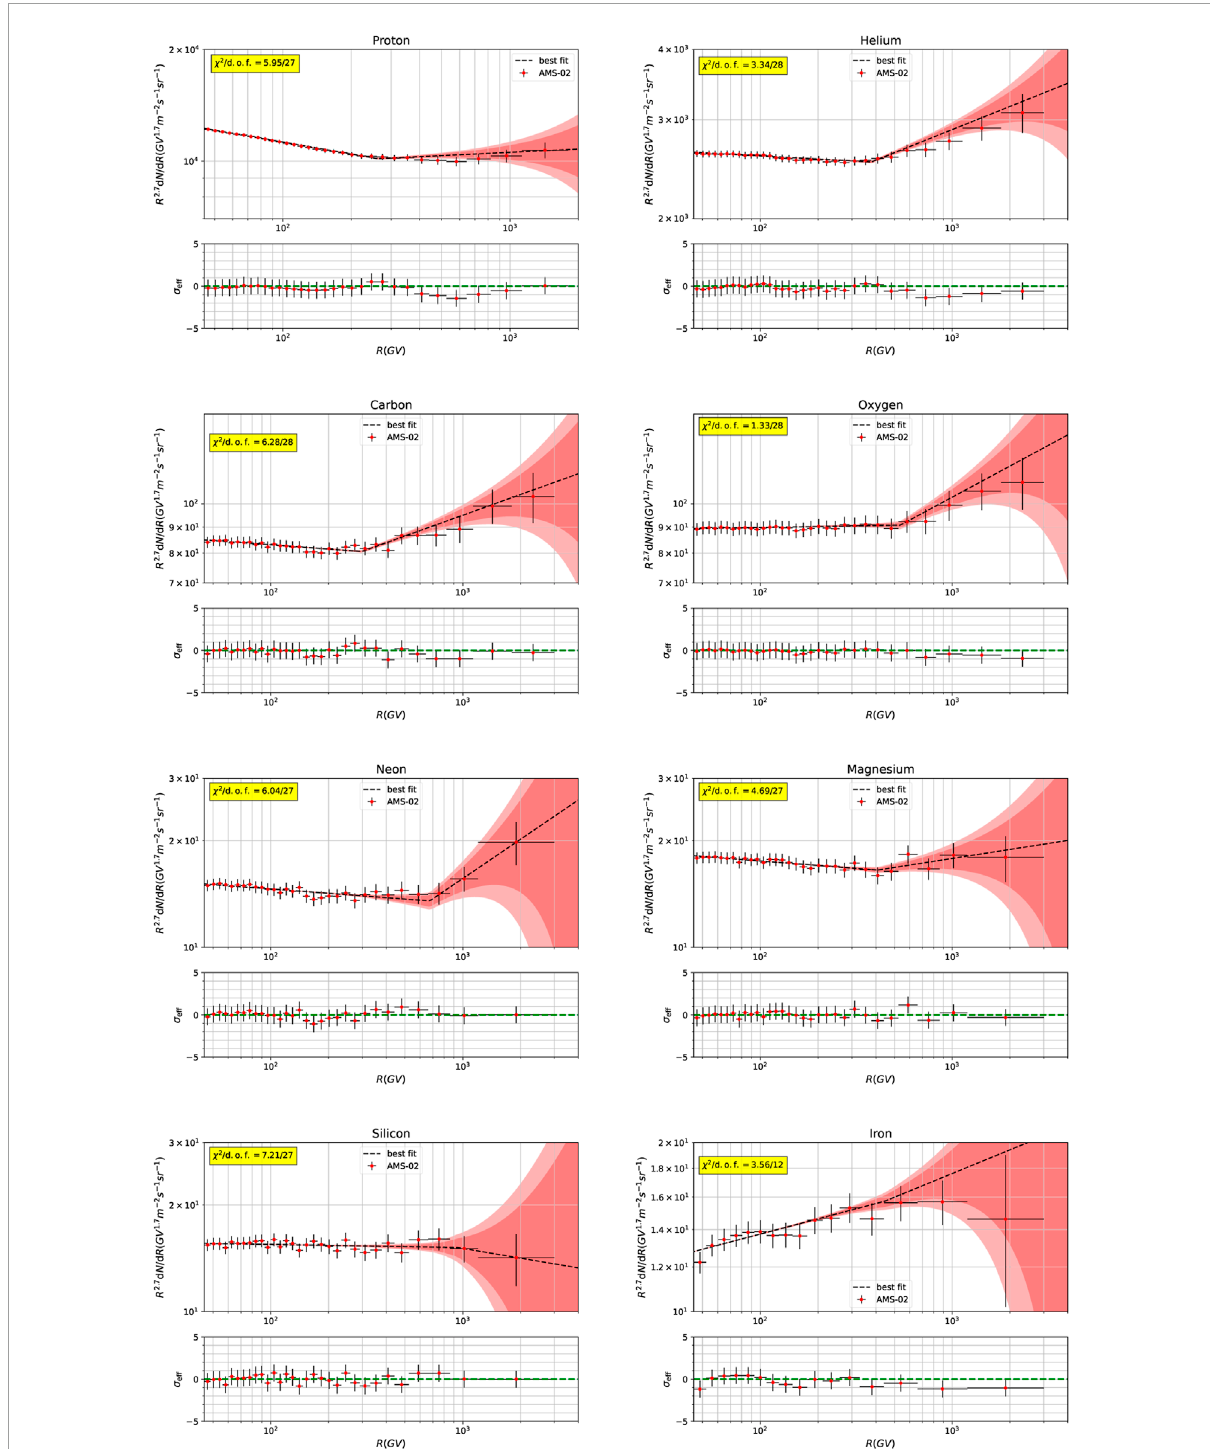
FIGURE 1 Fitting results and corresponding residuals to the primary CR nuclei spectra (proton, He, C, O, Ne, Mg, Si, and Fe). The 2 σ (deep red) and 3 σ (light red) bounds are also shown in the subfigures. The relevant reduced χ 2 value of each spectrum is given in the subfigures as well.